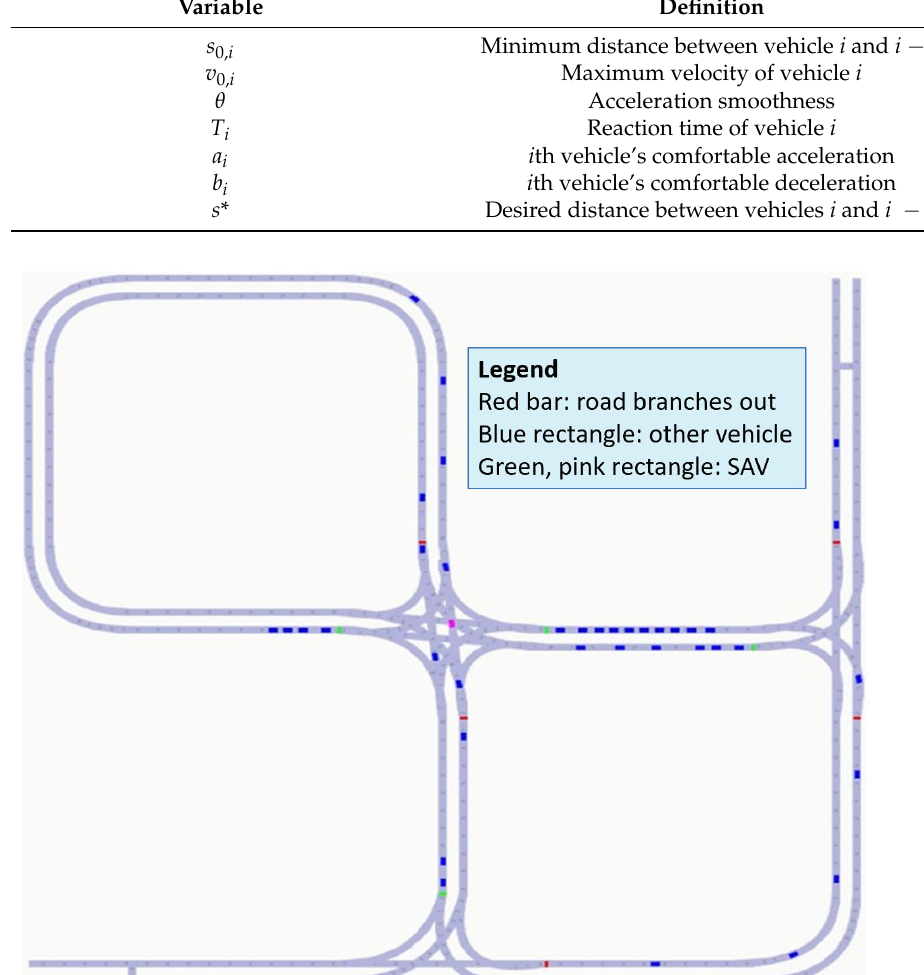
Figure 10. Created RL environment.